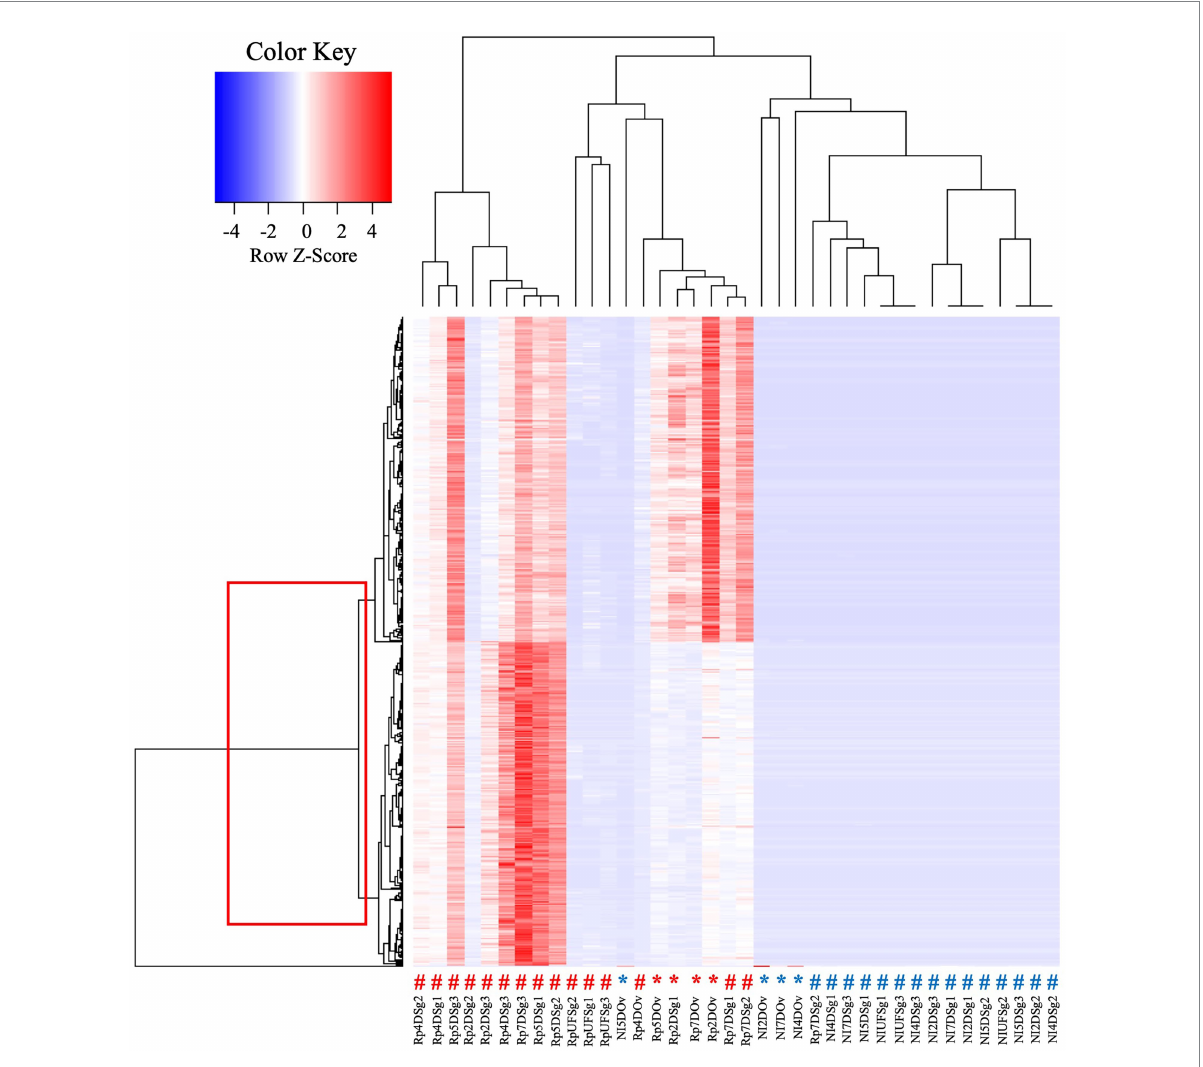
FIGURE 4 Heat map analysis of transcripts from CMM in salivary glands and ovaries of R. parkeri -infected and non-infected A. maculatum ticks. The box indicates two clusters of transcripts. The # symbols indicate results for salivary gland transcripts, and the * indicate those for ovary transcripts, their red color indicating results for R . parkeri infected and the blue symbols for non-infected ticks. Rp, Rickettsia parkeri -infected; NI, non-infected; Sg, salivar glands; Ov:ovary; D, day of feeding. A more detailed description of the experimental condition of each sample can be found in the Supplementary Spreadsheet